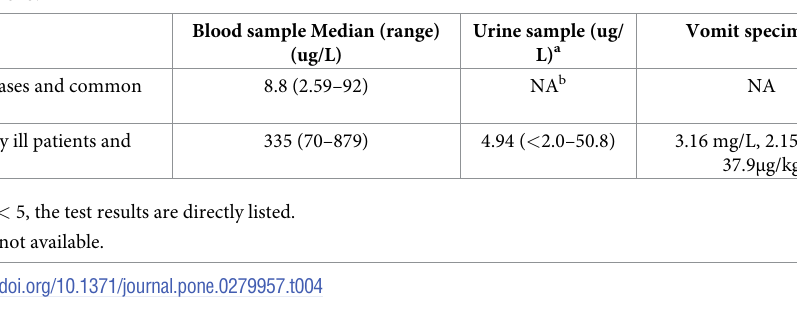
(Table 3). Patients who died manifested decreased blood coagulation, acute liver function loss, myocardial damage, impaired renal function and other multiple organ failure, and a few fatali- ties also experienced high potassium, low blood pressure, shortness of breath, cyanosis of the lips and fingernails, and cardiac arrest. Fever symptoms mainly occurred in an outbreak involving 52 cases. Convulsions, irritability, and chest tightness were also noted in a few patients.